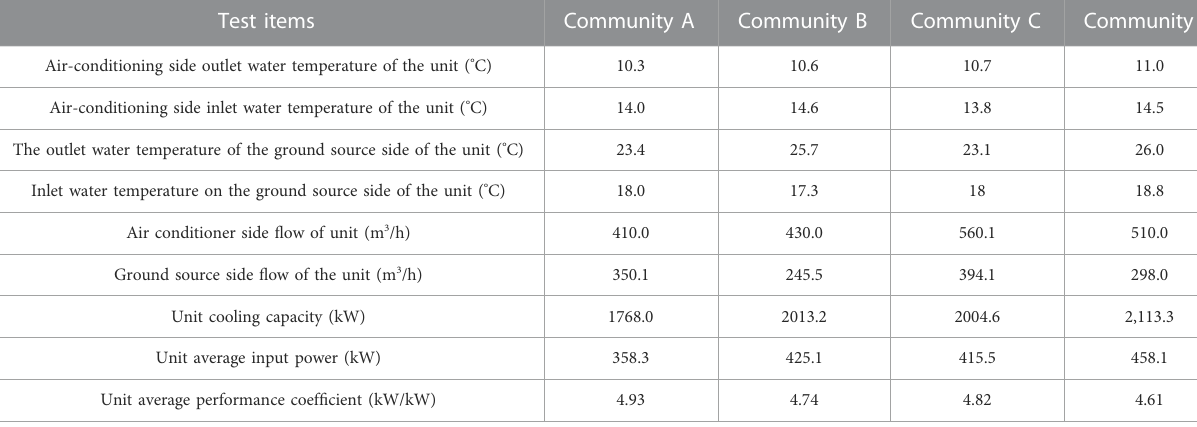
TABLE 3 Refrigeration performance test results under actual operating conditions. Test items